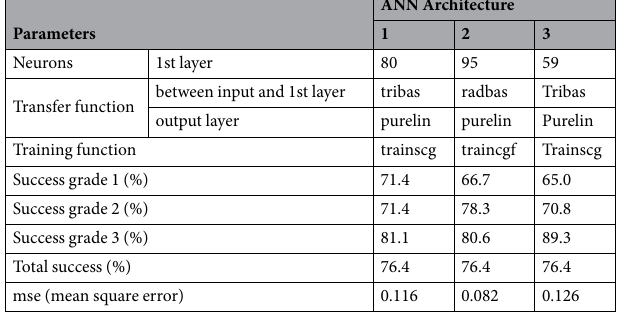
Table 1. Parameters of the best ANN architectures obtained using the GA.